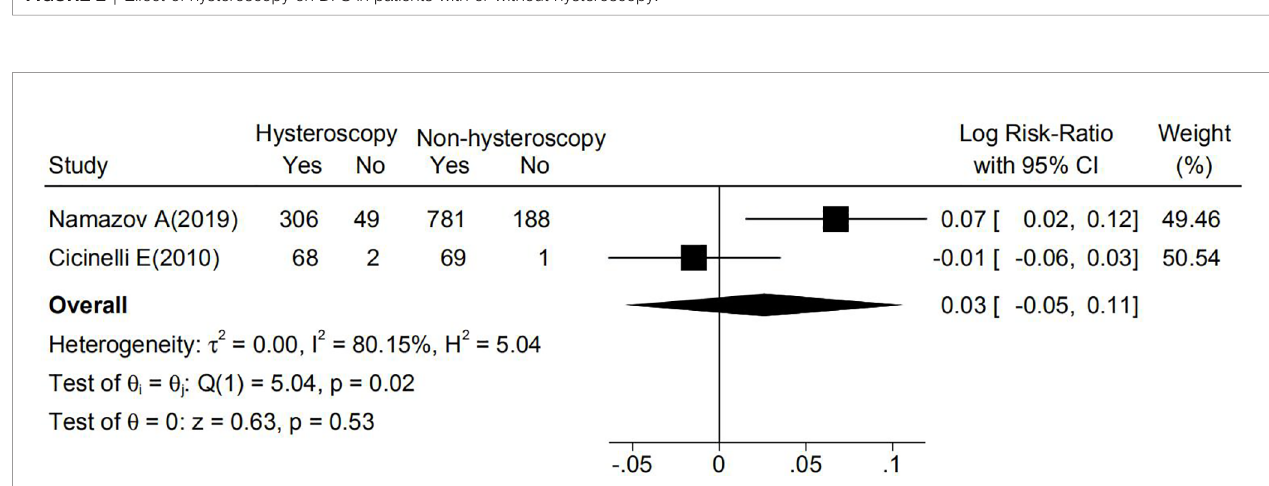
FIGURE 2 | Effect of hysteroscopy on DFS in patients with or without hysteroscopy.